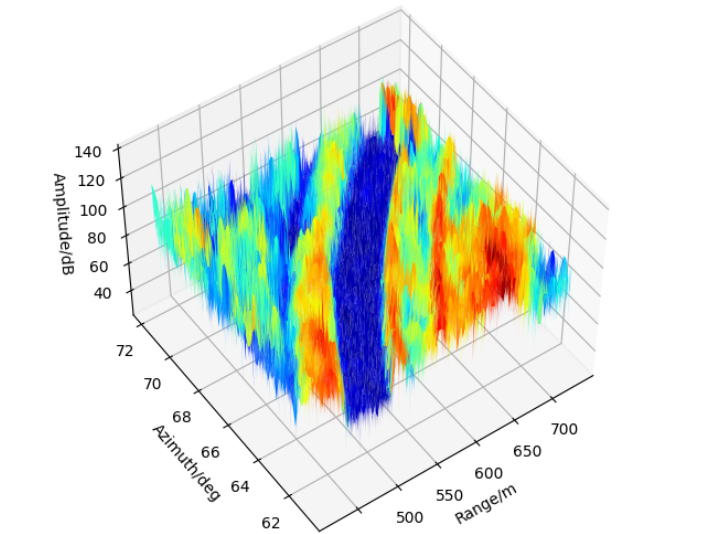
Figure 9. The establishment of background clutter map in 3D